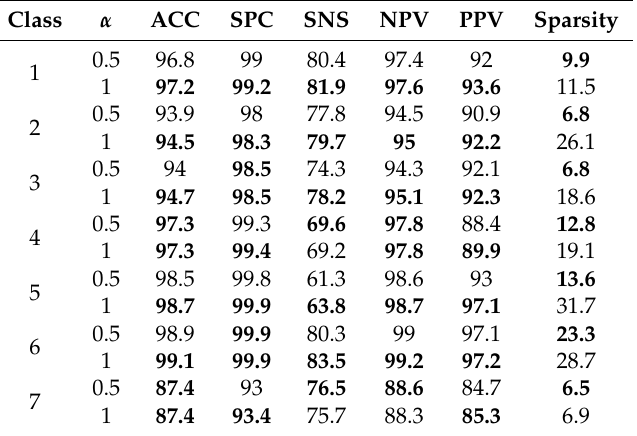
Table 3. Average results (in percentage) on Test Set for ν -SVM. In bold, the best between the two fitness function tradeoff values for α